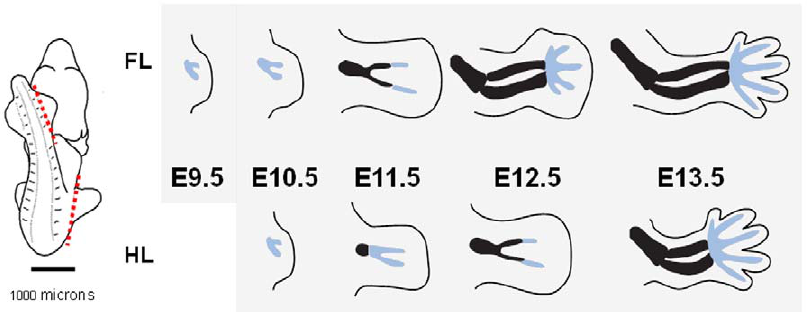
Figure 1. Limb Bud Morphology. Fore- and hind-limb buds were cut away from the embryo body as indicated by the red dash and RNA was processed from the full appendages outlined for stages E9.5 to E13.5. Light blue indicate mesenchymal condensations, and cartilage as determined by alcian blue staining is marked by thick black lines. Hindlimbs are morphologically delayed by , half a day.